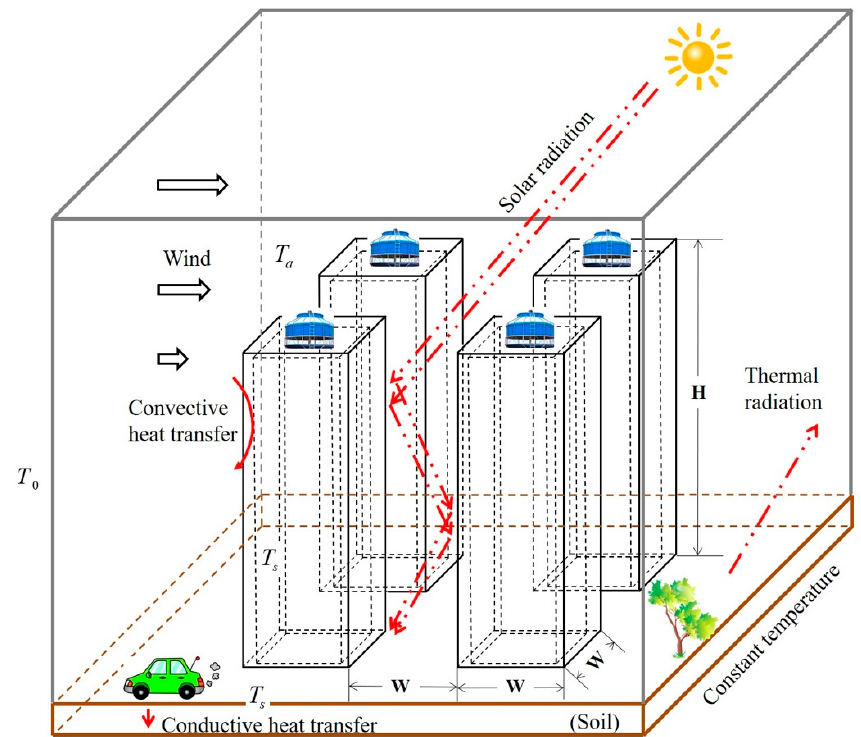
Figure 5. A sketch of the simplified ideal city.